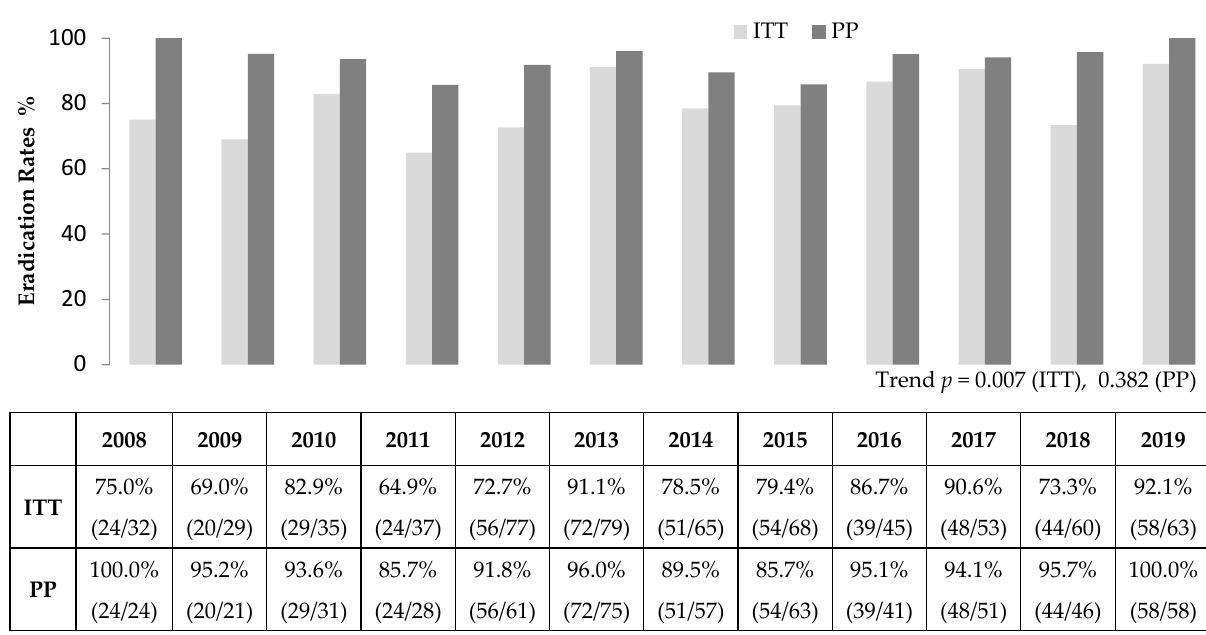
Figure 2. Annual Helicobacter pylori eradication rates of second-line bismuth containing quadruple therapy. ITT, intention-to-treat; PP, per-protocol. Table 2. Cumulative eradication rates per year-periods.